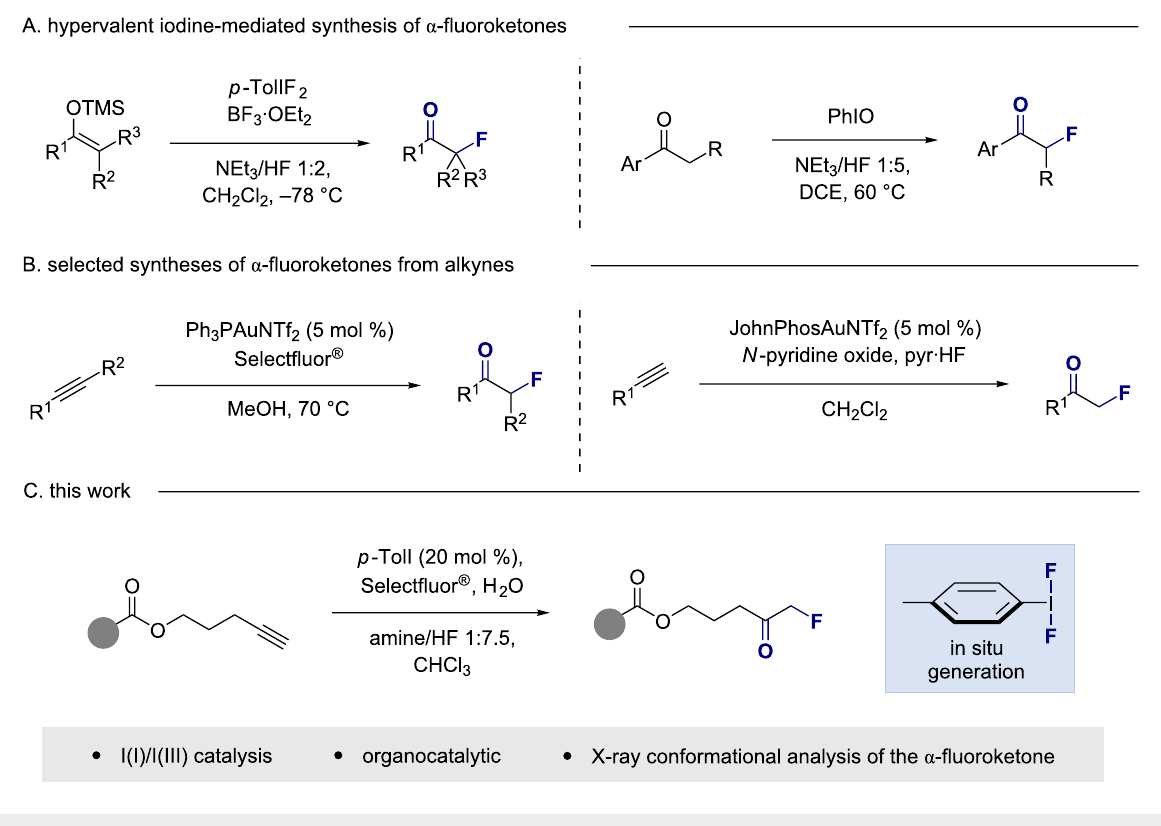
Figure 1: (A) Synthetic routes to α -fluoroketones from silyl enol ethers or acetophenone derivatives. (B) Selected Au-catalysed syntheses of α -fluo- roketones from alkynes. (C) This work: synthesis of α - fluoroketones from pentynyl benzoates via I(I)/I(III)